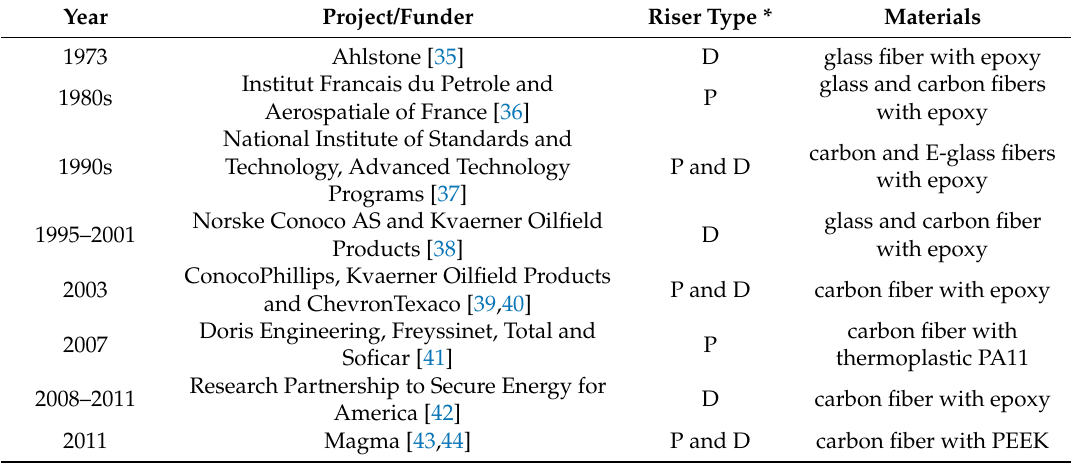
Table 1. A summary of previous joint industry projects on composite